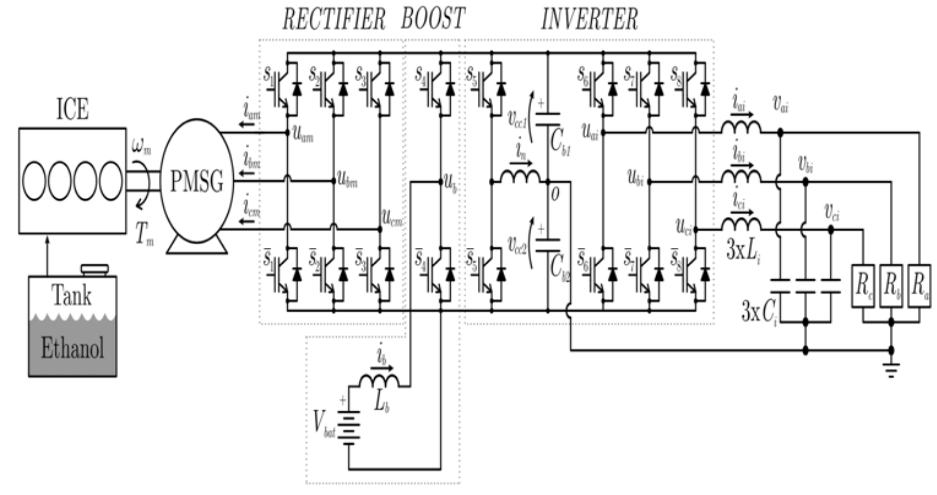
Figure 10. Variable speed stop-start technique for engine generator [70].